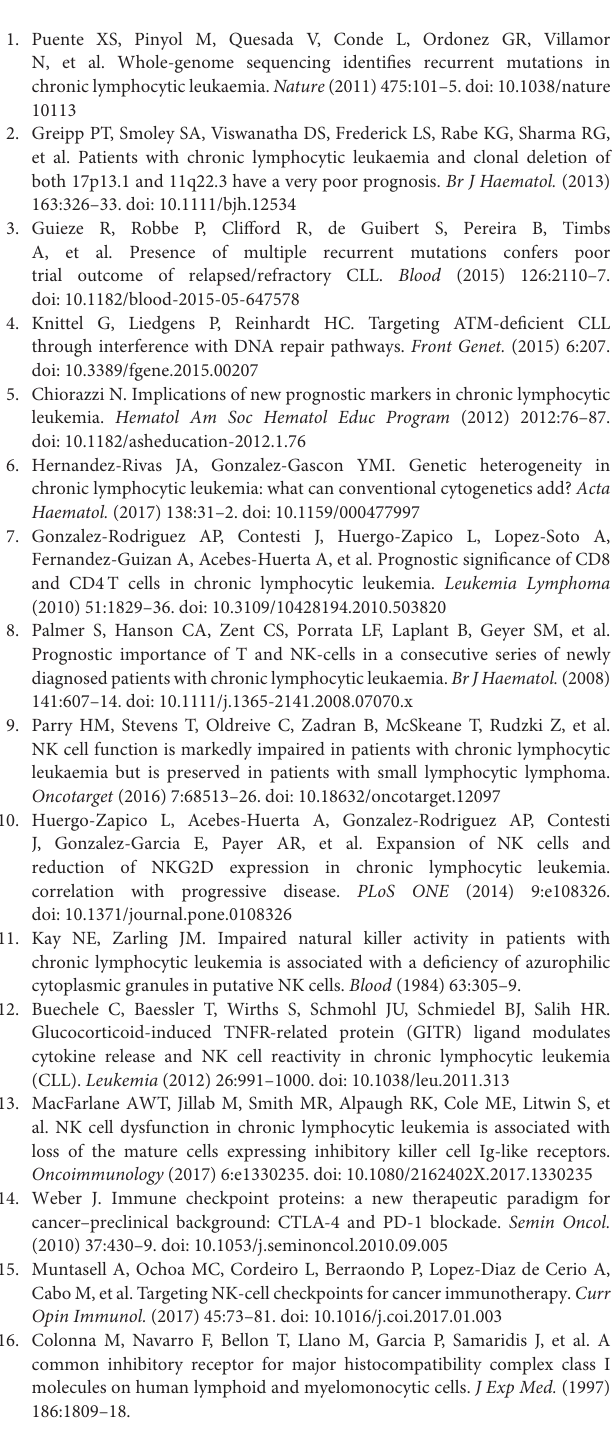
blocking antibody (10 µ g/ml) or irrelevant IgG 1 and lenalidomide (LND, 1 µ M), IL-2 (50 U/ml) or the combination for 7 days. Bars represent the MFI ± SEM for each condition. SEM, Standard Error of the Mean; Wilcoxon Matched-Pairs Signed Ranks test; ∗ P <